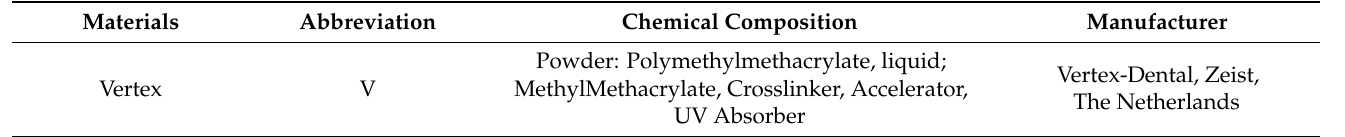
Table 1. Brand names, abbreviations, chemical compositions and manufacturers of the materials used in this